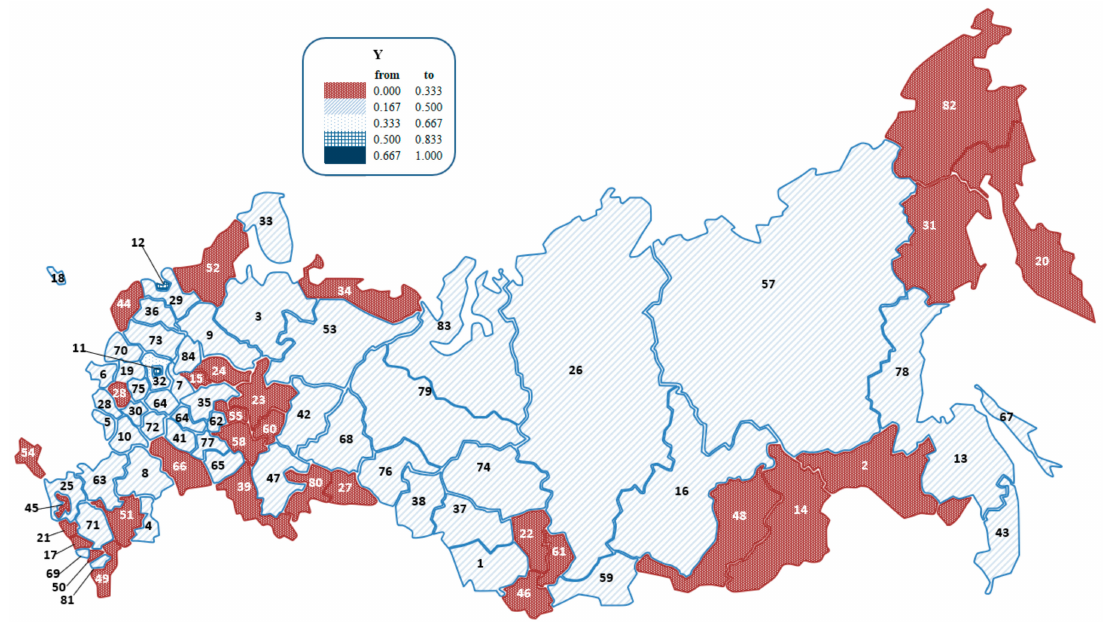
Figure 4. Distribution of the indicator “the level of readiness of the region for digitalization of the construction complex” on a geographical map of Russia, 2017.